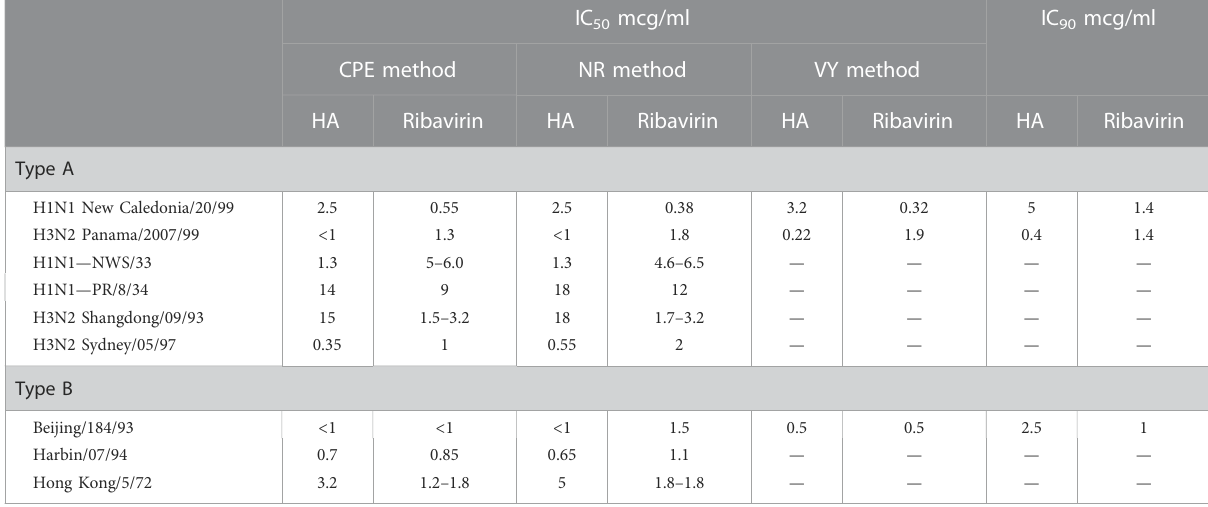
TABLE4Effectiveinhibitoryconcentrationat50%(IC 50 )and90%(IC 90 )ofhumicacid(HA)andribavirinreferencecompoundwithin fl uenzavirus,TypesAand B, in MDCK cells (NIH,